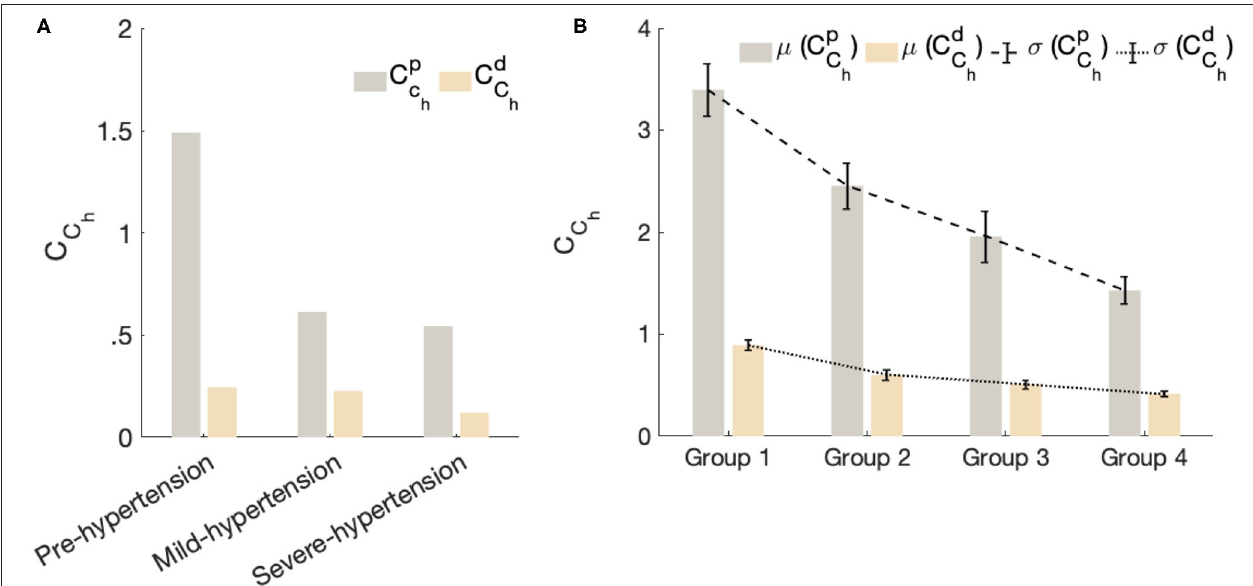
) and distal ( C d C h h ) fractional order compliance for the in-human